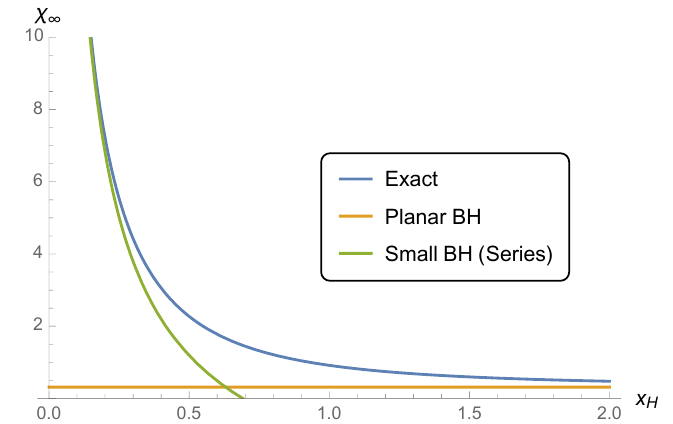
Figure 4 . The blue line plots (cid:31) 1 , the yellow line represents the planar black hole result, and the green line plots the truncated series of (cid:31) 1 near x H = 0 given in eq.